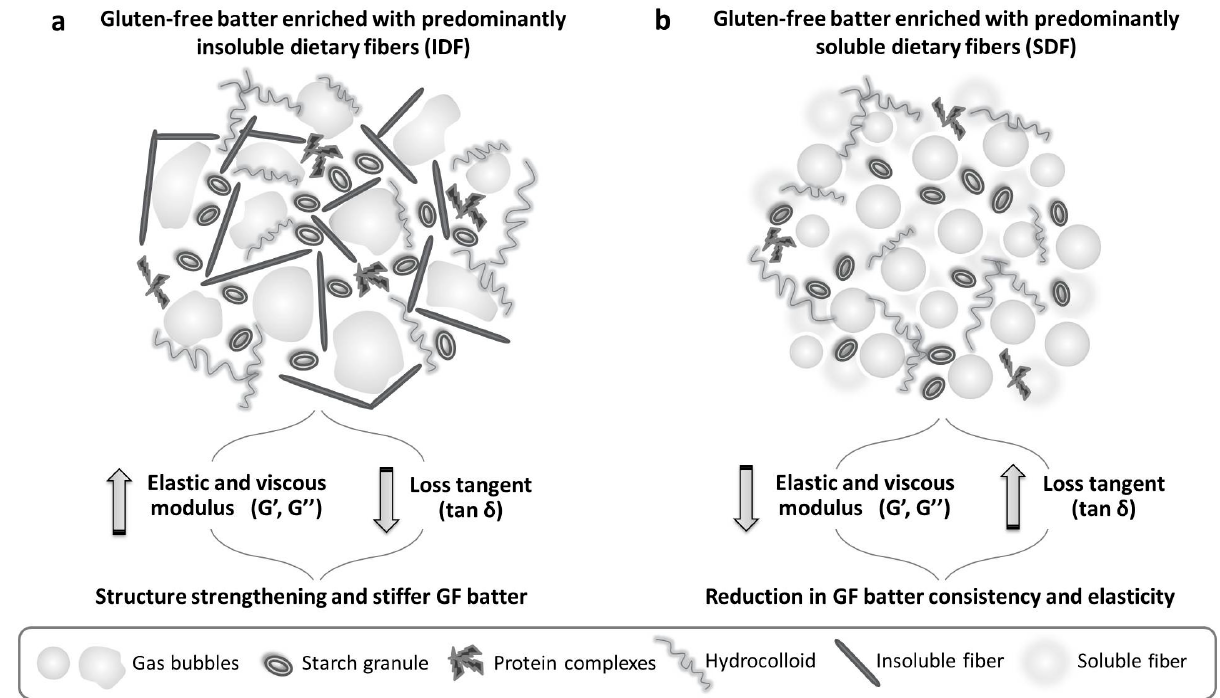
Figure 1. Microstructure of gluten-free batters enriched with ( a ) predominantly insoluble and ( b ) soluble dietary fiber.